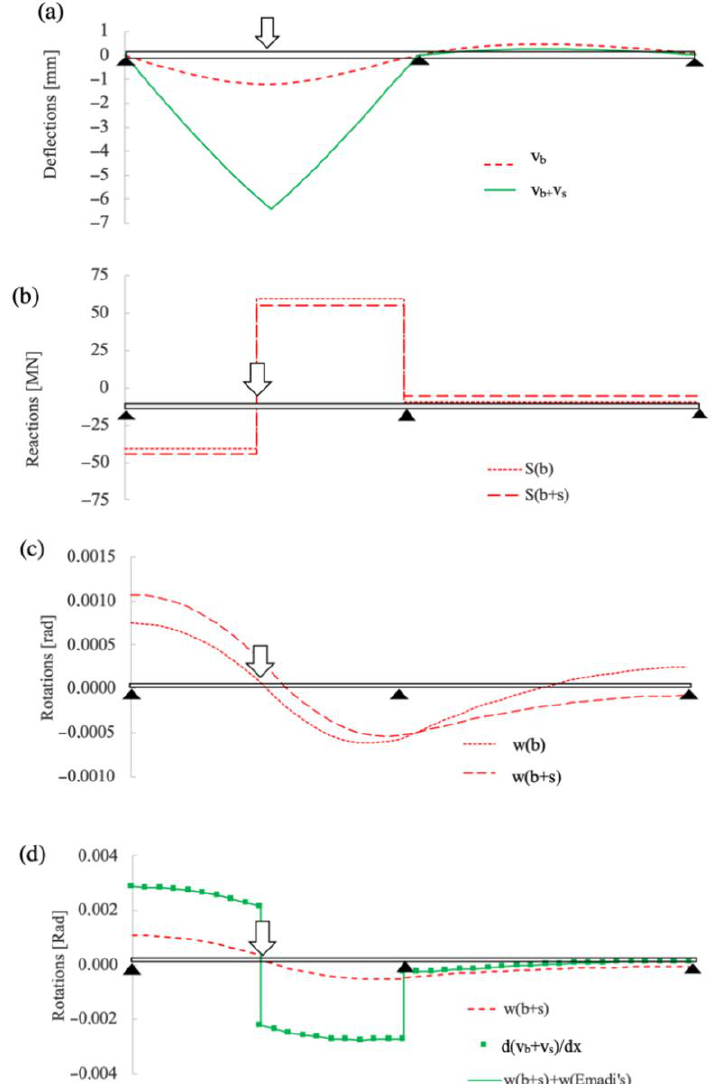
Figure 5. Example 2: continuous beam with and without shear effects: ( a ) vertical deflections, ( b ) shear diagrams, ( c ) rotations obtained with the commercial software, and ( d ) rotations including shear effects.